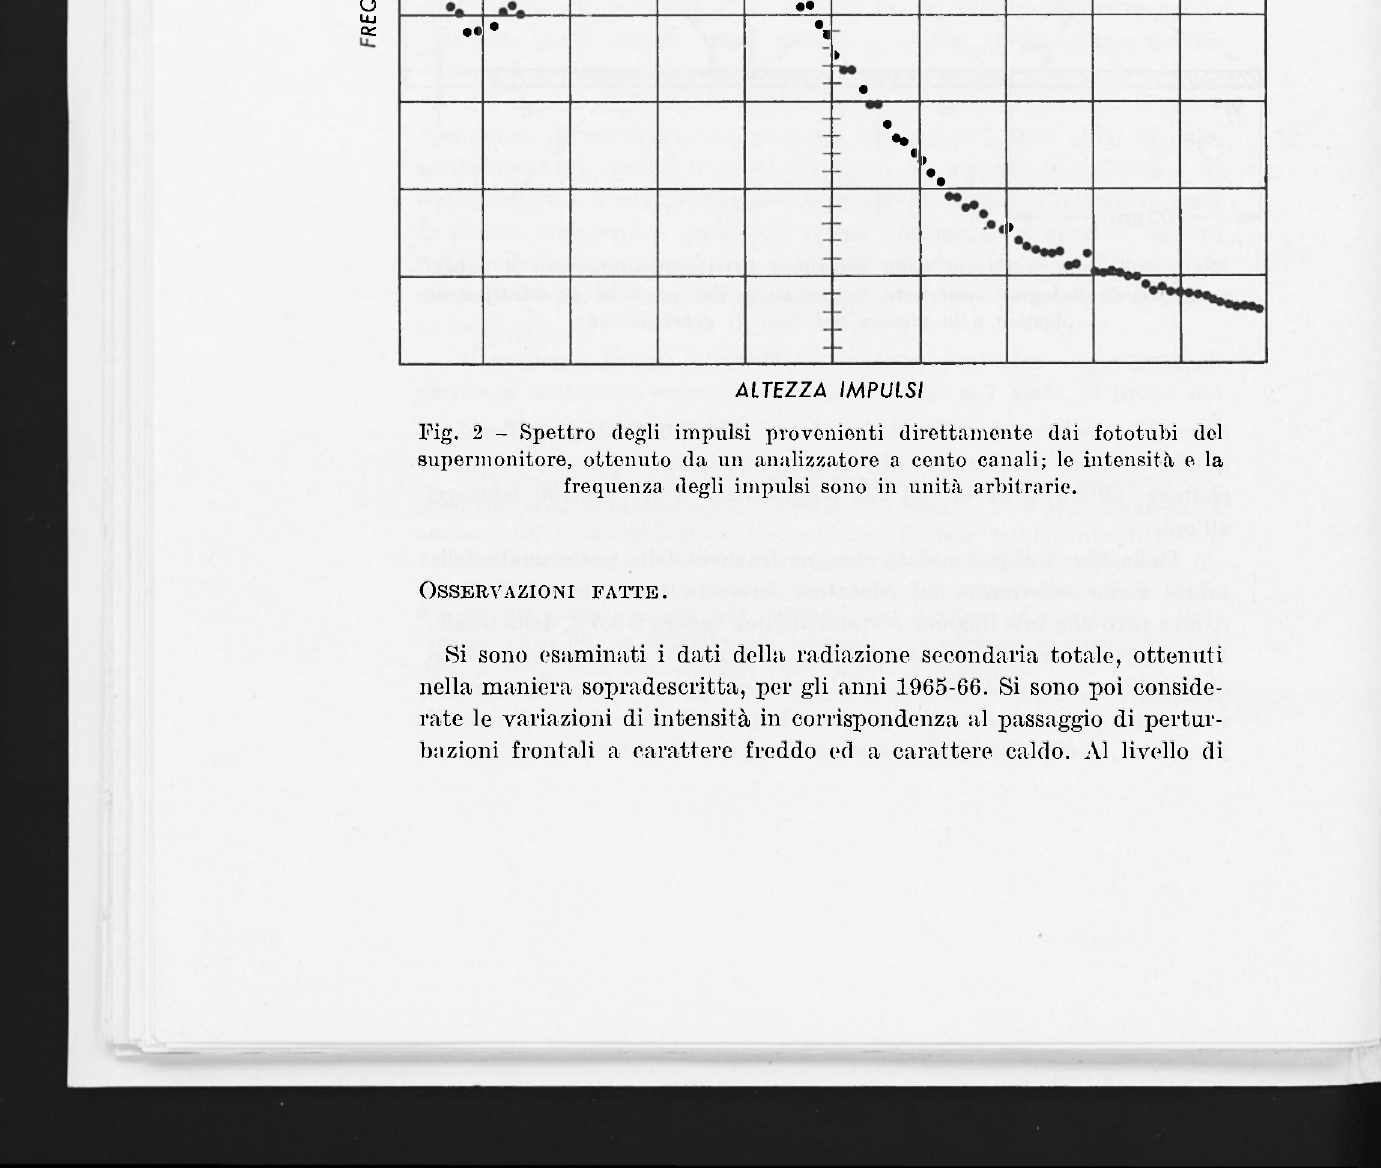
Fig. 2 - Spettro degli impulsi provenienti direttamente dai fototubi del supermonitore, ottenuto da un analizzatore a cento canali; le intensità e la frequenza degli impulsi sono in unità arbitrarie.